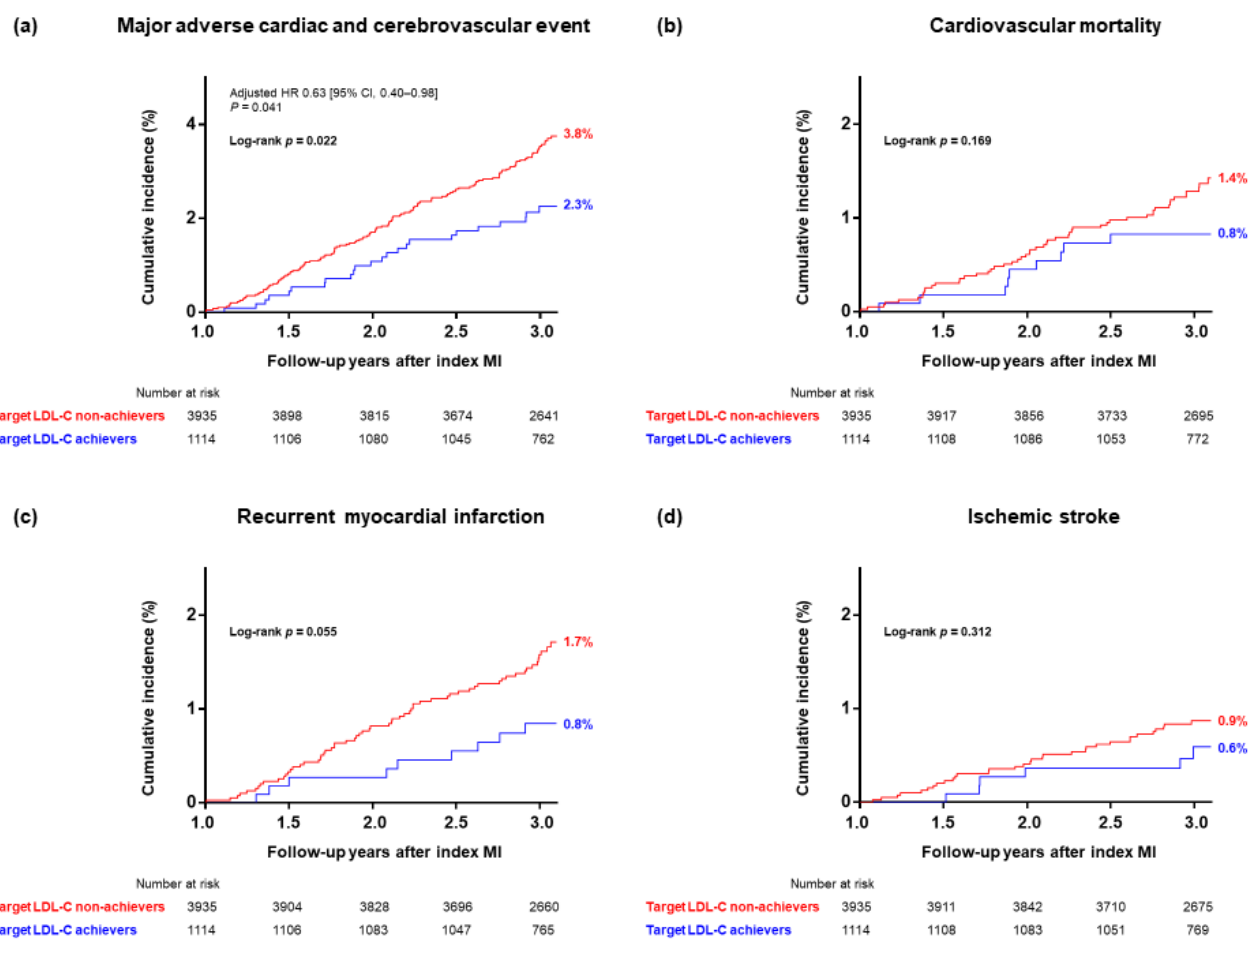
Figure 2. Cumulative incidence of ( a ) major adverse cardiac and cerebrovascular event, ( b ) cardiovascular mortality, ( c ) recurrent myocardial infarction, and ( d ) ischemic stroke according to the attainment of target LDL-C levels. CI, confidence interval; HR, hazard ratio; LDL-C, low-density lipoprotein cholesterol; MI, myocardial infarction.